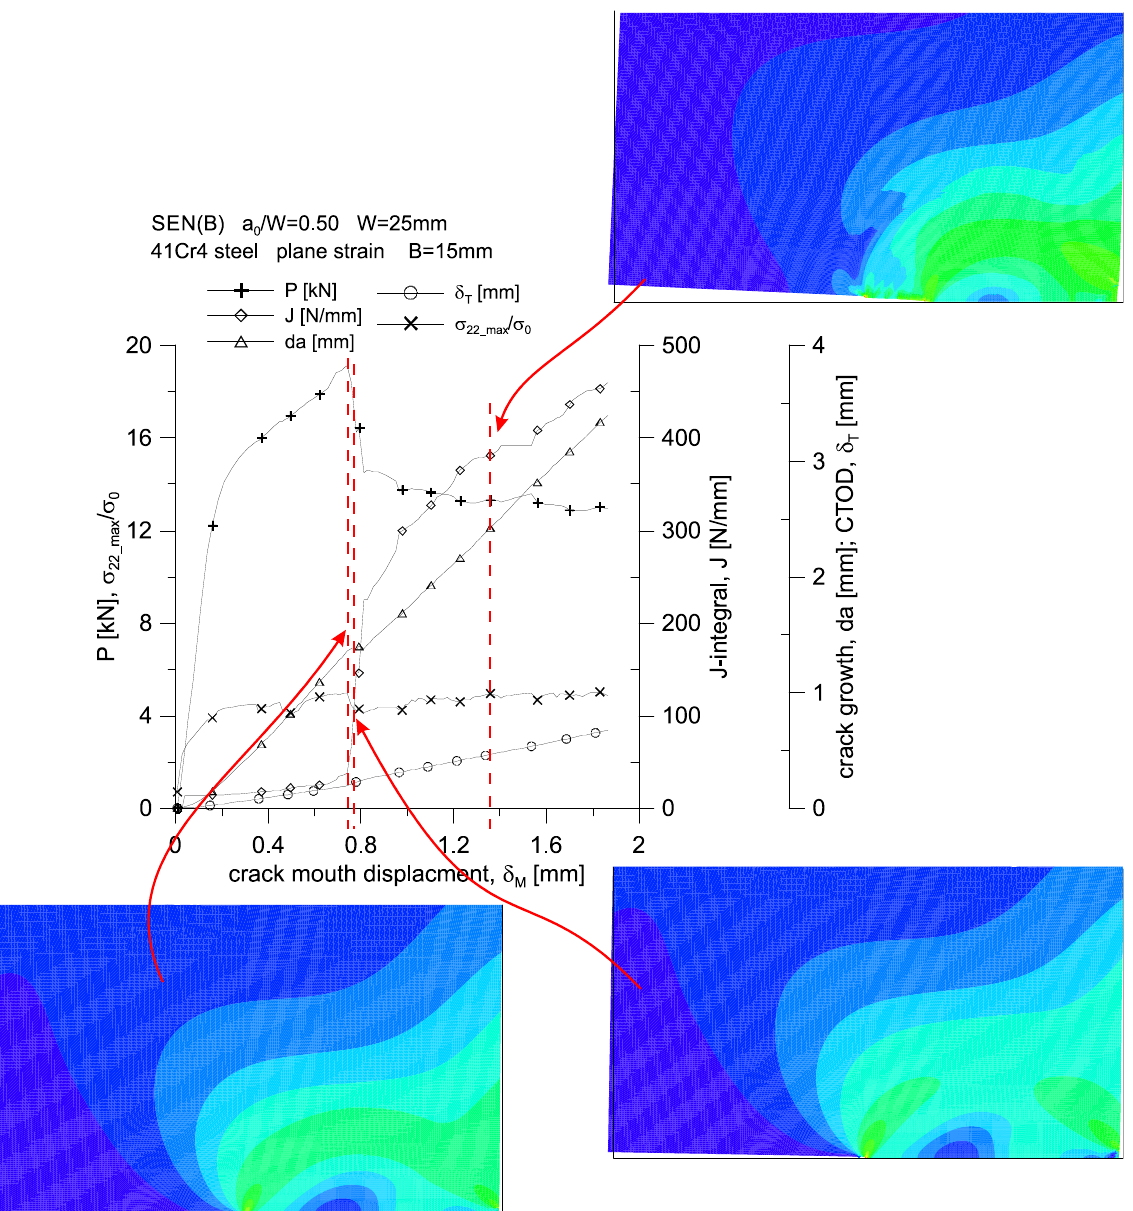
Figure 20. Changes of: the force, P, loading the specimen, the value of the J ‐ integral, the crack length increment, da , the crack tip opening displacement, δ T , and the maximum stresses opening the crack surfaces, σ 22_max / σ 0 , as a function of the crack mouth displacement, δ M , together with the distribution of effective stresses in close proximity to the crack tip. 41Cr4 steel specimen with a thickness of B = 15 mm.